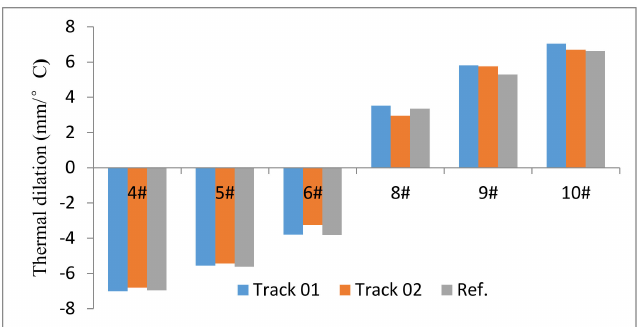
Figure 11. Thermal dilations measured by Track 01, Track 02, and the